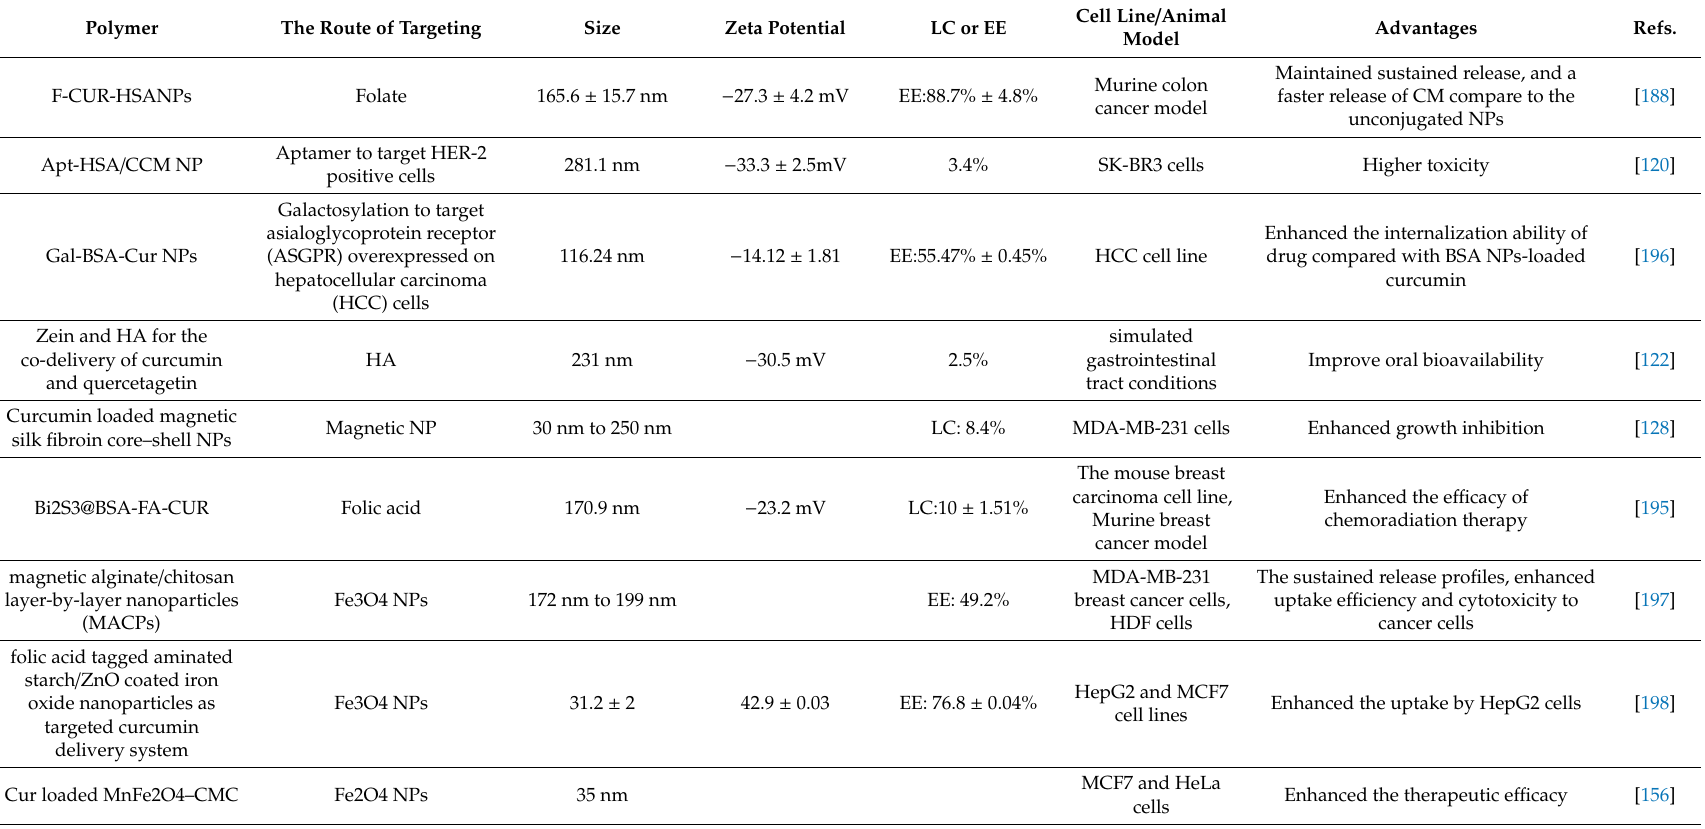
Table 2. Targeted curcumin delivery using biopolymers-based